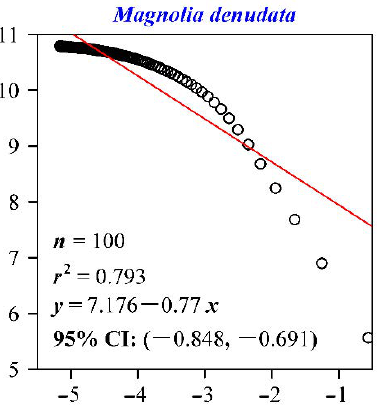
Figure 7. Sample calculations of the leaf vein fractal dimension. Here, δ represents the box size; N represents the number of boxes, and each box includes at least one leaf vein pixel; n represents the number of box sizes for each leaf; r 2 is the coefficient of determination. The absolute value of the slope represents the leaf shape fractal dimension, and 95% CI represents the 95% confidence intervals of the slope. In this example, the length of a side of the candidate box ranges from z /2000 to z /20, where z represents the maximum between the x -coordinate range and the y -coordinate range of leaf vein pixels.